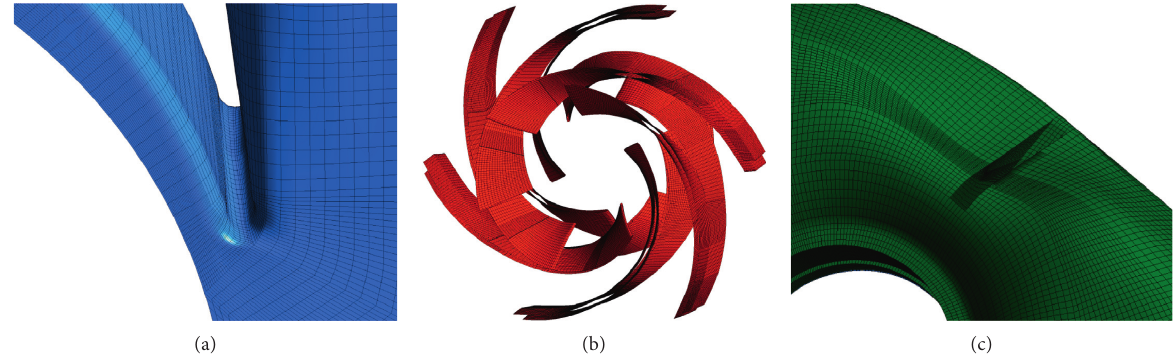
Figure 2: Mesh of calculation domain: (a) volute tongue, (b) impeller, and (c) suction tongue.